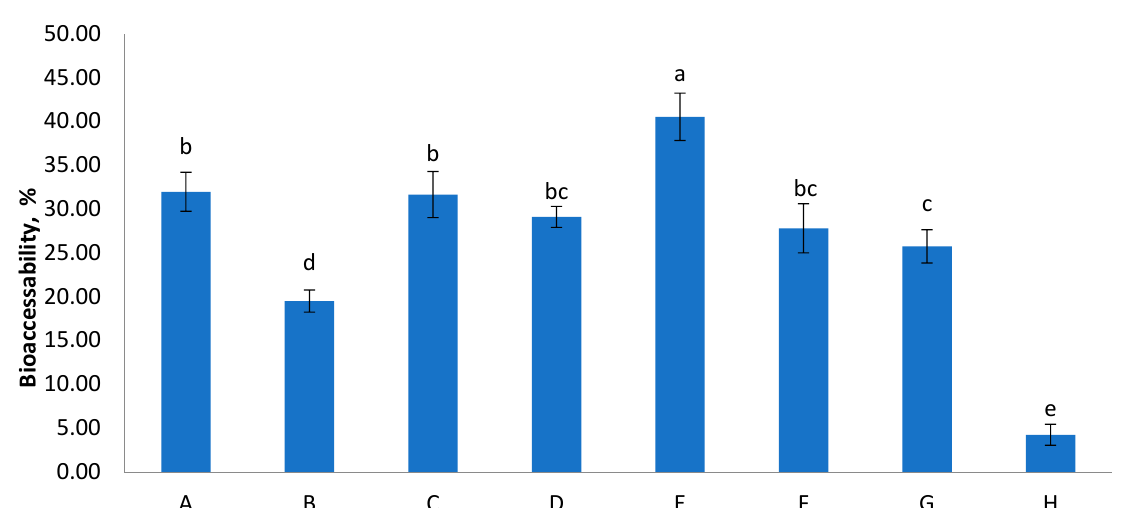
Figure 1. Bio-accessibility of total sugars from the digested juices (%). Values are means ± SEM, n = 3 per treatment group. Means in a chart column without a common superscript letter differ ( p < 0.05) as analysed by one-way ANOVA and the TUKEY test. Table 4. Bio-accessibility (BA, %) of phytochemicals after in vitro digestion *.